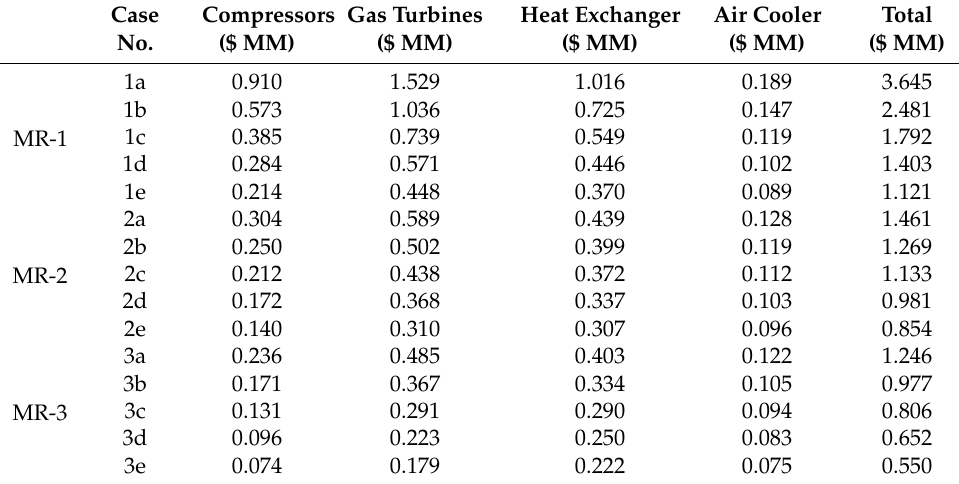
Table 9. Cost of individual major equipment of proposed pre-cooling cycle.